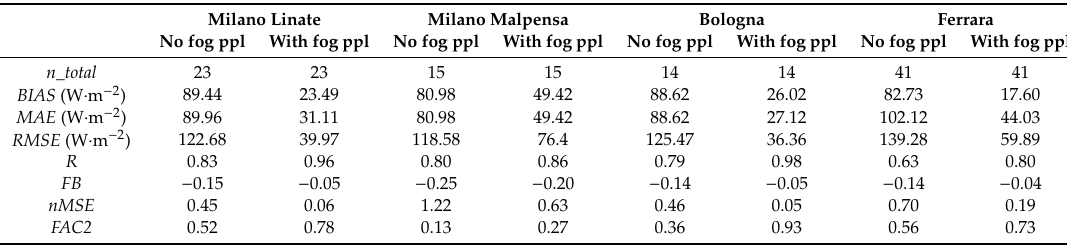
Table 14. Comparison of GHI WRF output performances with or without the application of fog postprocessing layer